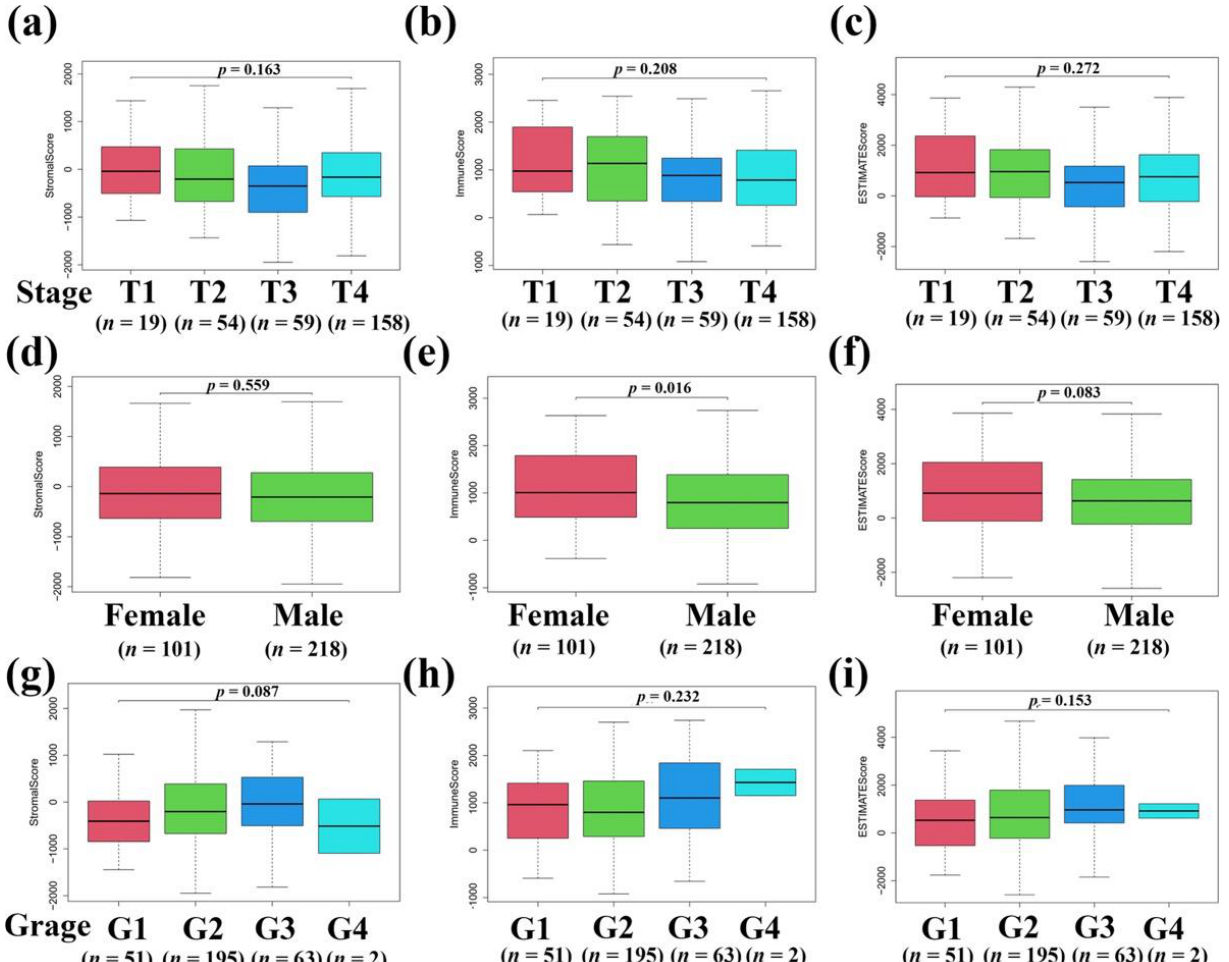
Figure 2. The relationship between stromal/immune/ESTIMATE scores and clinical features of OSCC patients. ( a ) Relationship between stromal scores and TNM stages of OSCC patients. ( b ) Relationship between immune scores and TNM stages of OSCC patients. ( c ) Relationship be- tween ESTIMATE scores and TNM stages of OSCC patients. Sample numbers of each group are as follows: T1, n = 19; T2, n = 54; T3, n = 59; T4, n = 158. ( d ) Relationship between stromal scores and genders of OSCC patients. ( e ) Relationship between immune scores and genders of OSCC patients. ( f ) Relationship between ESTIMATE scores and genders of OSCC patients. Sample numbers of each group are as follows: female, n = 101; male, n = 218. ( g ) Relationship between stromal scores and tumor grades of OSCC patients. ( h ) Relationship between immune scores and tumor grades of OSCC patients. ( i ) Relationship between ESTIMATE scores and tumor grades of OSCC patients. Sample numbers of each group are as follows: G1, n = 51; G2, n = 195; G3, n = 63; G4, n =